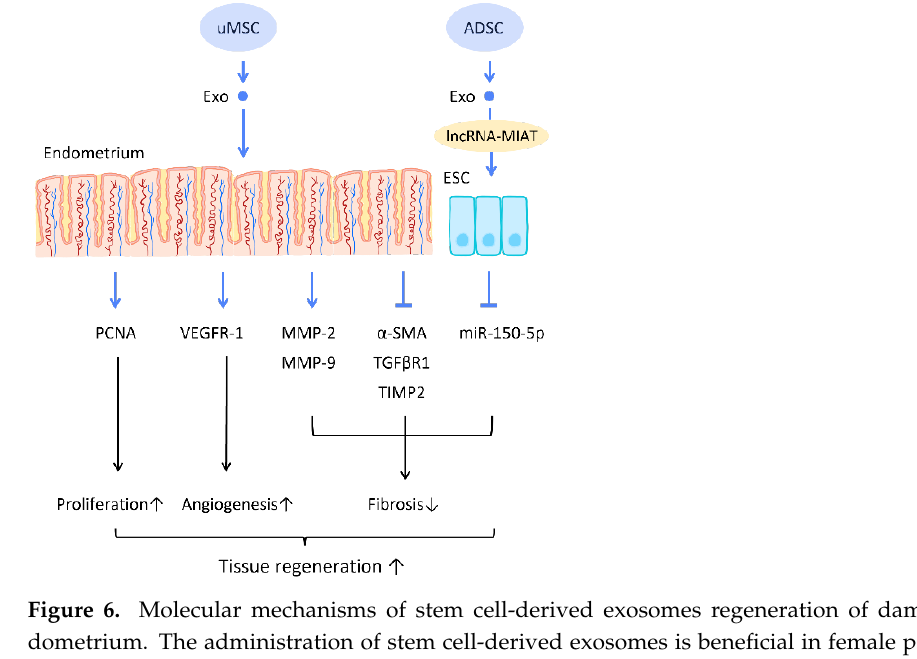
metalloproteinase; α -SMA: alpha smooth muscle actin; miR: micro-RNA. ↑ represents upregulation; ↓ represents